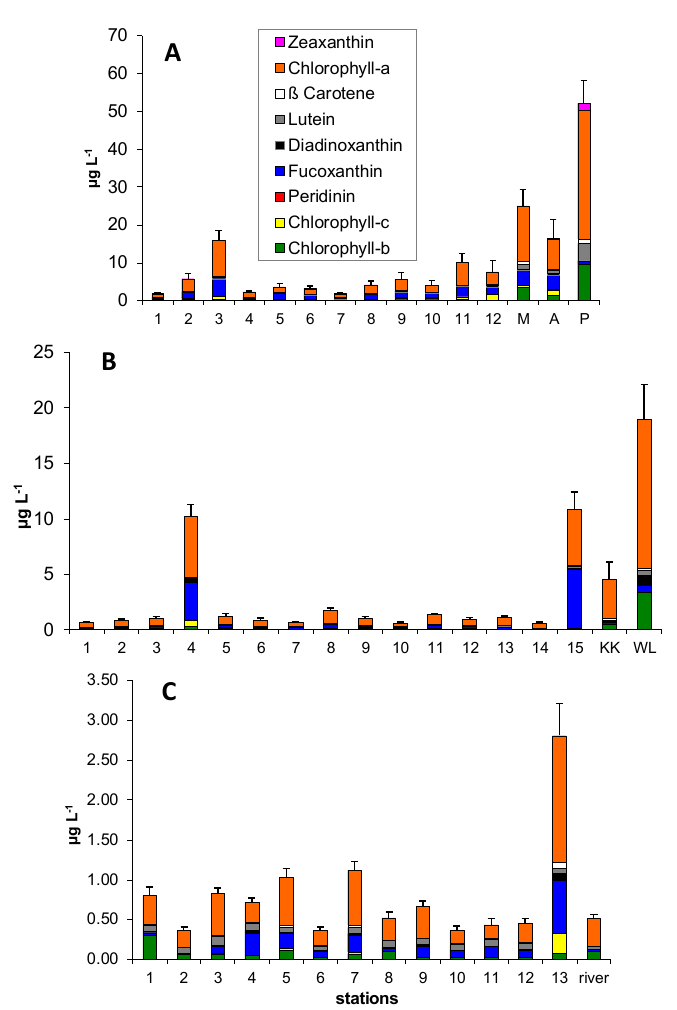
Figure 2. Annual mean concentration values of phytoplankton pigments in Jakarta Bay (upper graph ( A )), Lampung Bay (middle graph ( B )), and Semangka Bay (lower graph ( C )). Bars are standard deviations calculated from six data points. M = Marunda river mouth; A = Angke river mouth; P = Priok river mouth (upper graph). KK = Kota Karang river mouth; WL = Way Lunik river mouth (middle graph). R = Semangka river mouth (lower graph).